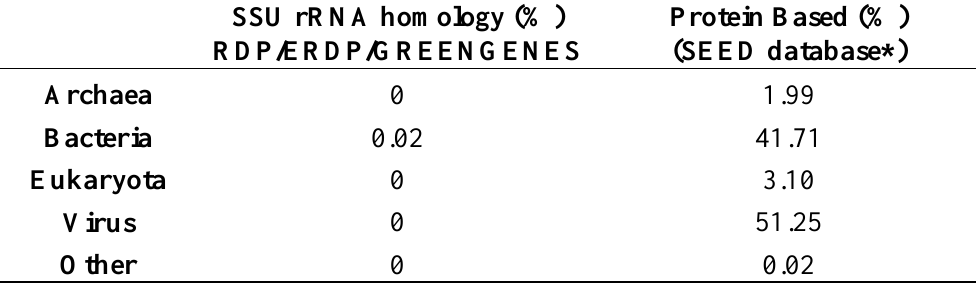
Table 2. MG-RAST sequence